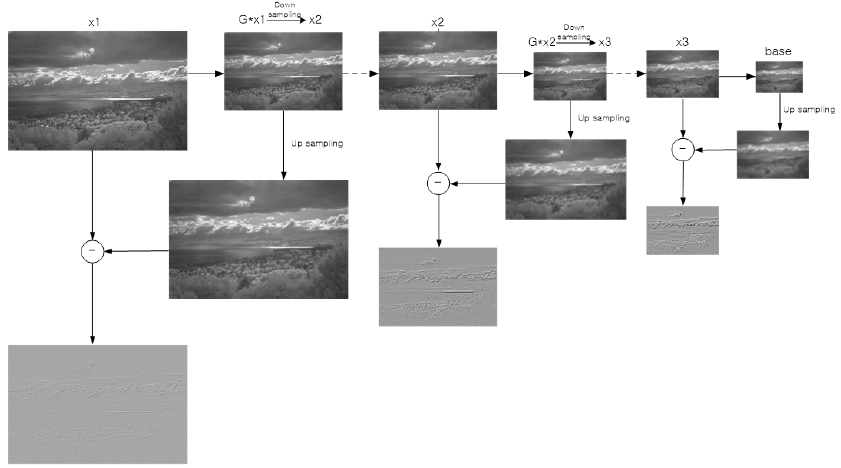
Figure 1. Laplacian pyramid block diagram.